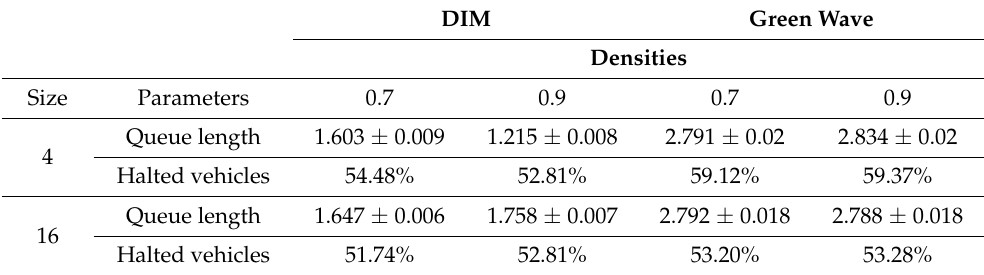
Table 2. Queue lengths and halted vehicles in cities with 500 m between intersections.